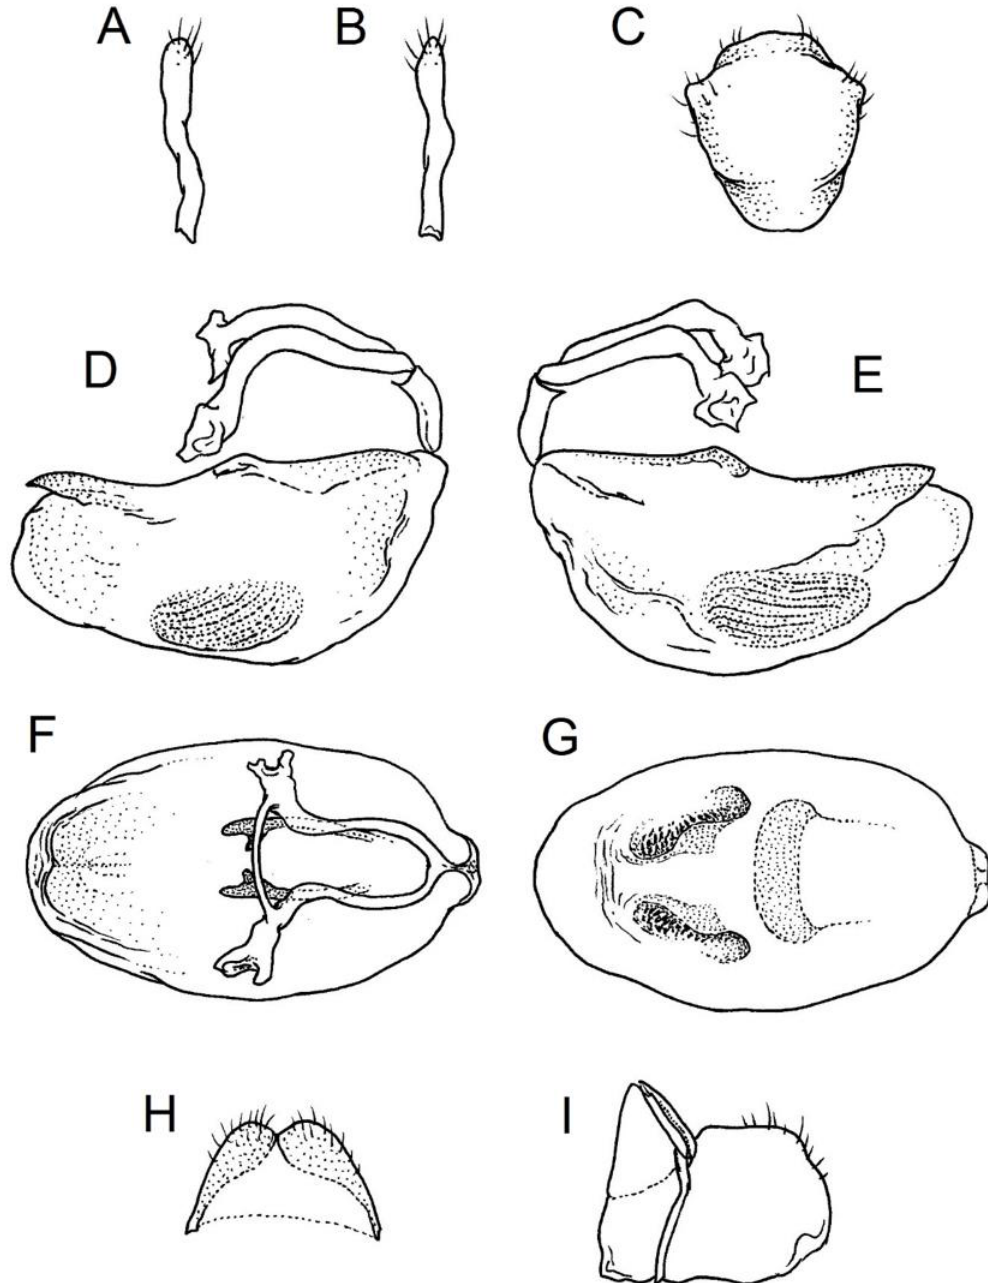
Figure 44. Phonoctonus immitis Stål, 1865: ( A ) left paramere; ( B ) right paramere; ( C ) pygophore, ventral view; ( D ) aedeagus, right lateral view; ( E ) aedeagus, left lateral view; ( F ) aedeagus, dorsal view; ( G ) aedeagus, ventral view; ( H ) styloids, outer view; and ( I ) gonocoxite of abdominal segment VIII.